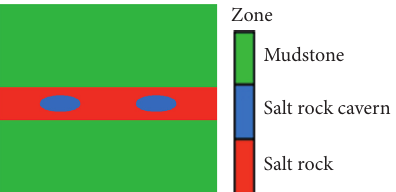
Figure 12: Numerical model of double-cavern horizontal salt rock underground storage ( d �